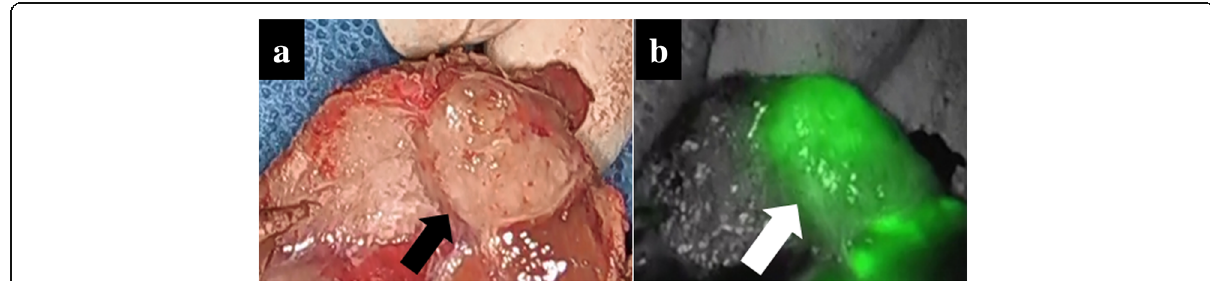
Fig. 3 a Cut surface of the surgical specimen. Resected specimen contained a 13-mm yellowish tumor (arrow) along the liver and diaphragm. b The presence of fluorescence in the tumor was confirmed with illumination using the ICG camera